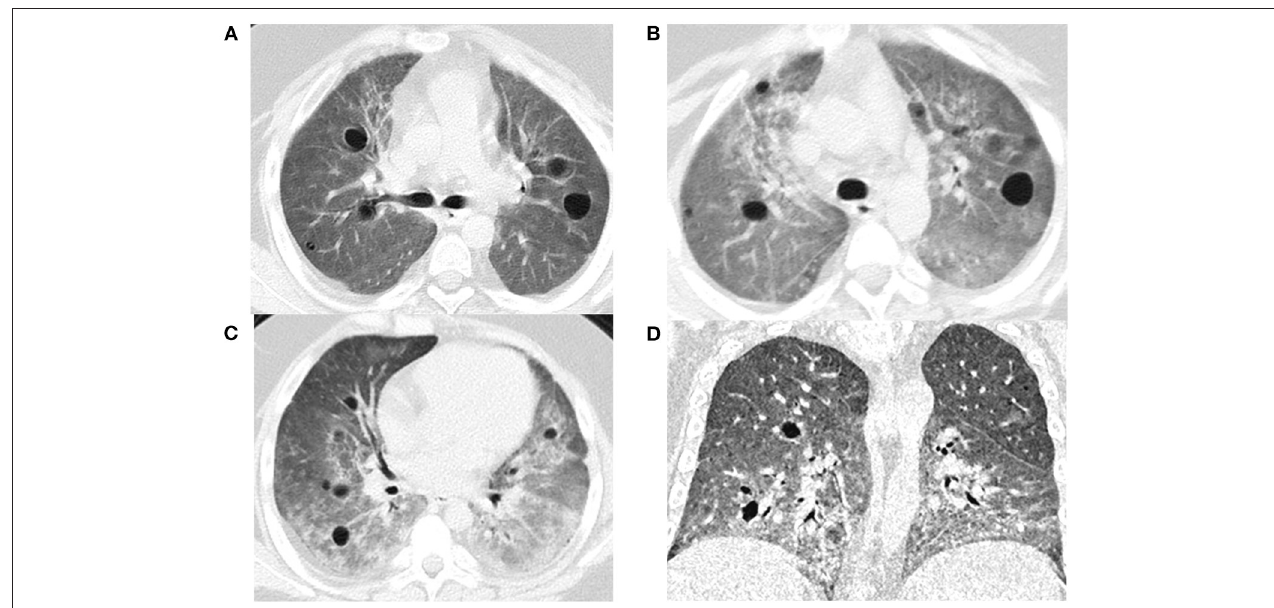
FIGURE 1 | The chest CT image: in lung window, bilateral diffuse ground glass opacities, varying sizes of cyst formation, and bronchial wall thickening in a bronchovascular ( A : Dec. 2015, B : June. 2017, C : Nov. 2018, D : Mar. 2019).